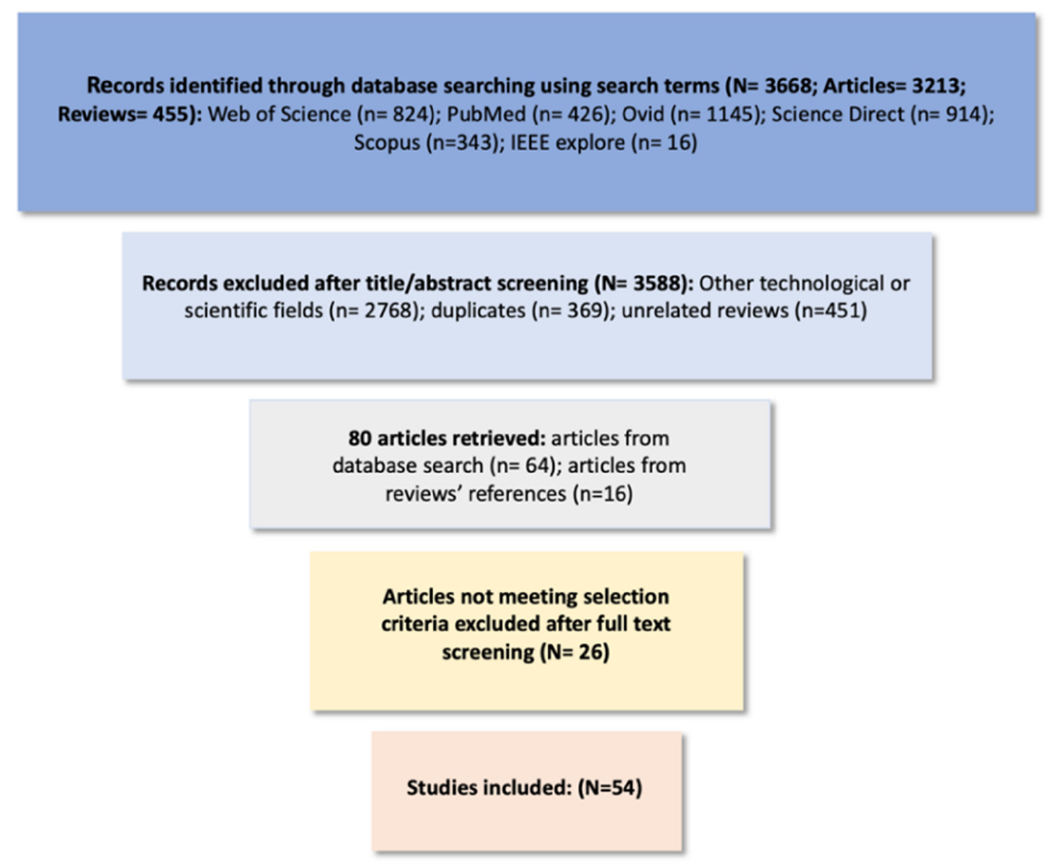
Sensors 2022 , 22 , x FOR PEER REVIEW